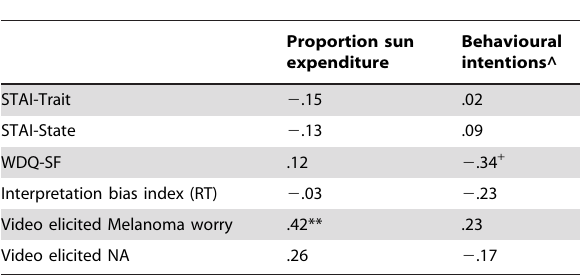
Table 2. Correlation between the two measures of engagement in sun protection with the anxiety, mood, worry and interpretative bias